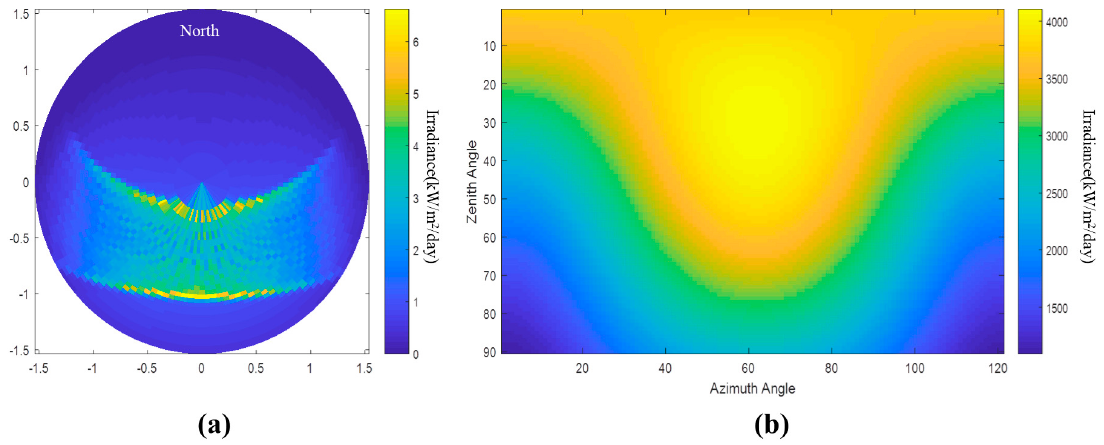
Figure 4. ( a ) Mean Sunmap of TMY dataset in Korea with a tilt angle 20°; ( b ) Mean total irradiance with respect to solar panel direction.